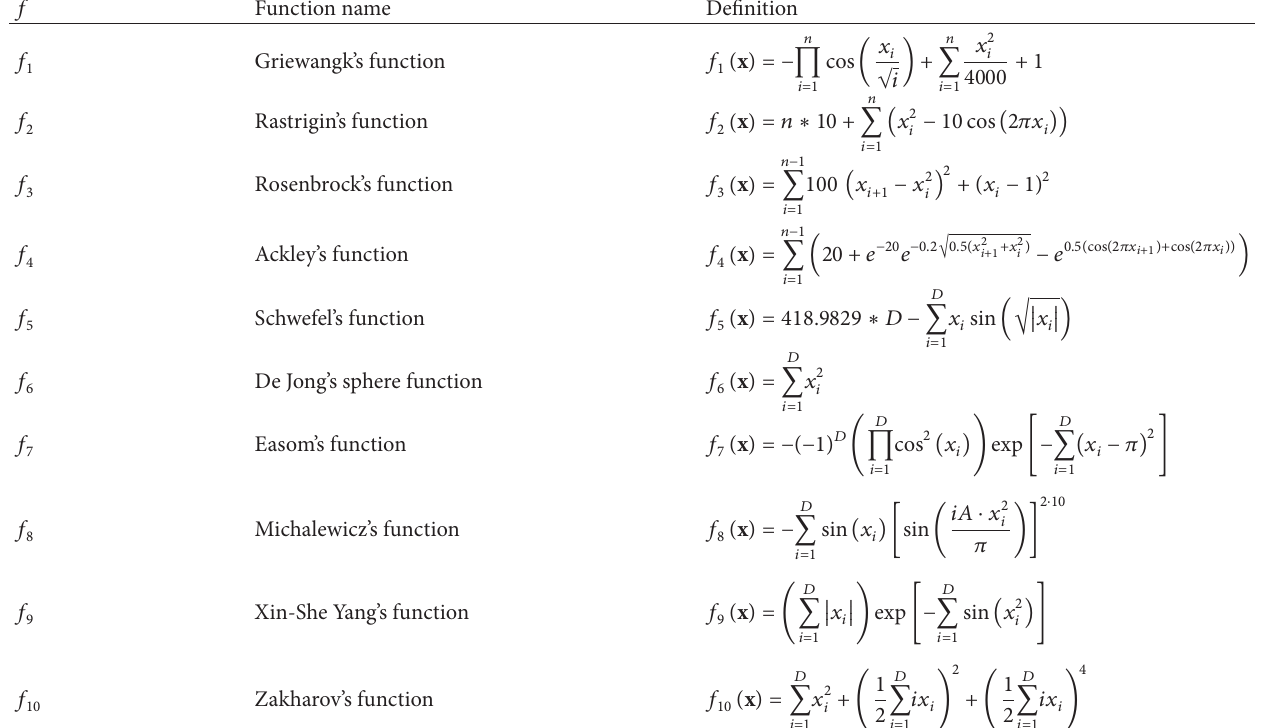
Table 1: Definitions of benchmark